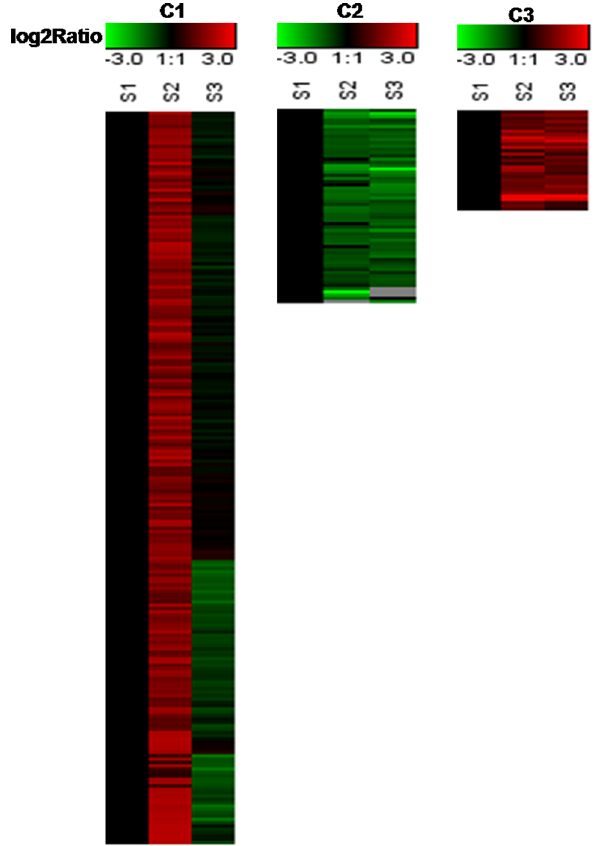
Figure 5. Expression patterns of the differentially expressed proteins. C1: Most of the differentially expressed proteins belong to cluster 1 were up-regulated in S2 and then down-regulated in S3; C2: Differentially expressed proteins belong to the cluster 2 were sustained down-regulated; C3: Differentially expressed proteins belong to the cluster 3 were sustained